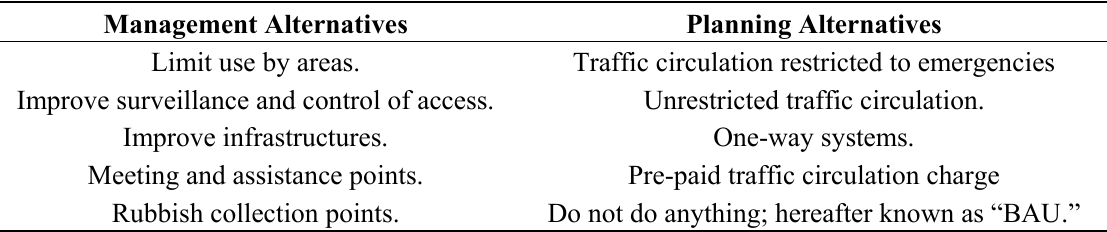
Table 3. Alternatives in forest planning and management.